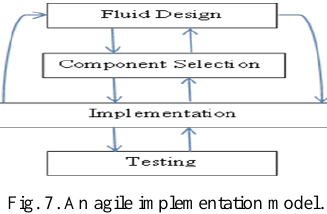
Fig. 7. An agile implementation